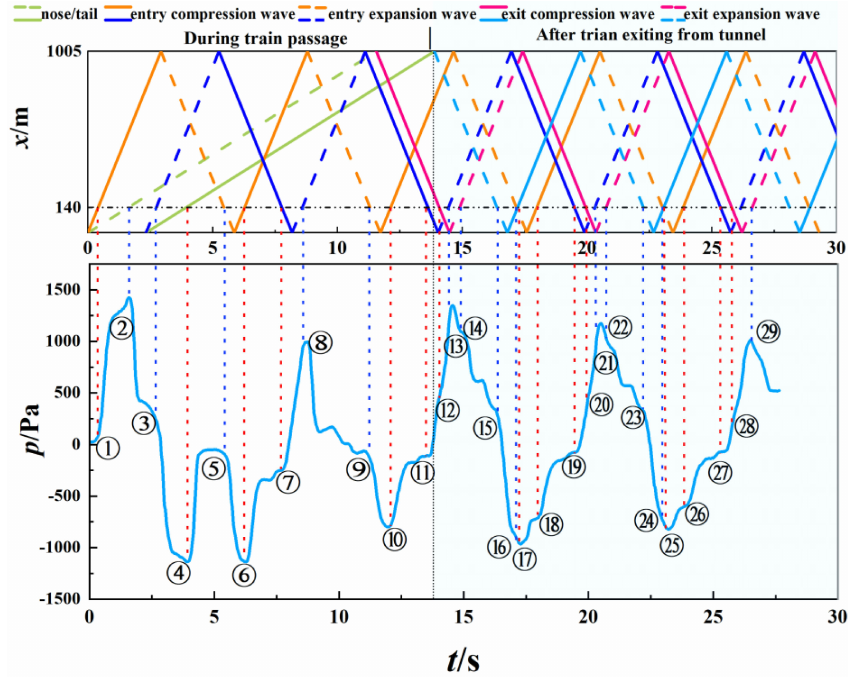
Figure 1. Pressure time histories at 140 m and associated wave diagram for a 201.4-m-long train passing through a 1005-m-long tunnel at 300 km/h (adapted from Liu et al.